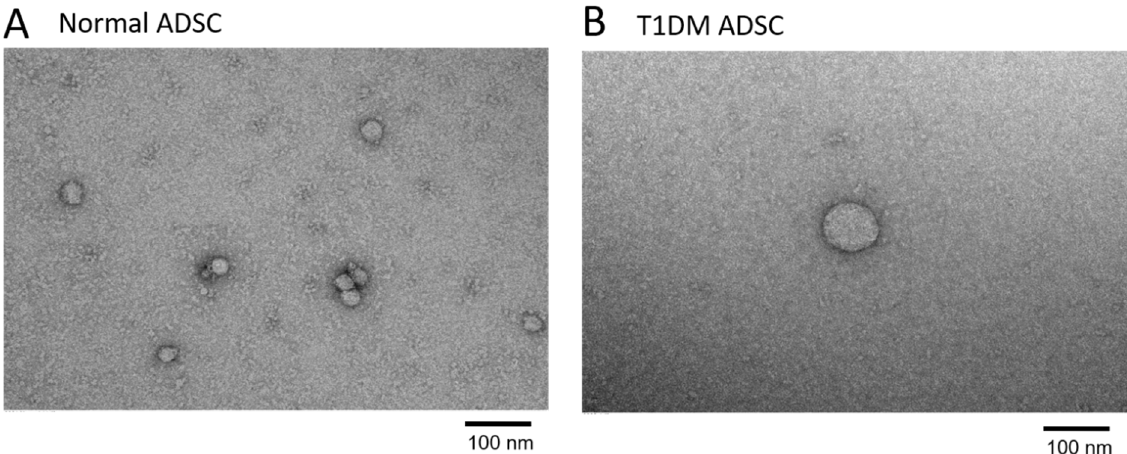
Figure 4. Electron microscopic images of exosomes. Transmission electron microscopic (TEM) images showing the morphology of exosomes extracted from adipose-derived mesenchymal stem cells (ADSCs). ( A ) An image of exosomes from normal ADSCs. ( B ) An image of exosomes from adipose-derived stem cells of patients with type 1 diabetes mellitus (T1DM ADSCs). The scale bar measures 100 nm.